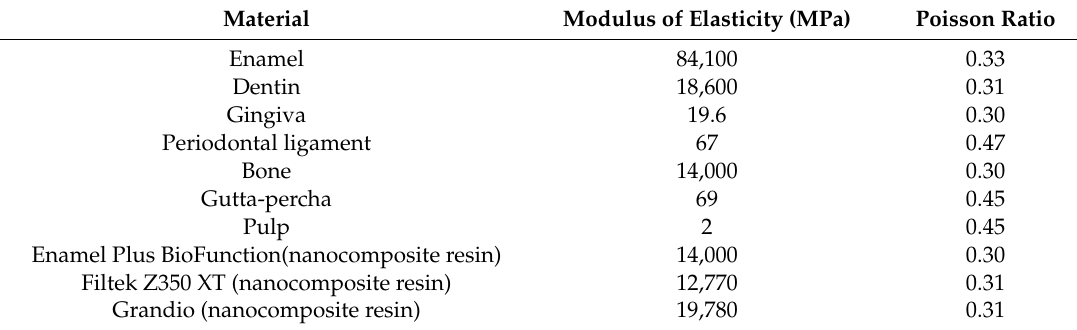
Table 1. Mechanical properties used for the isotropic materials included in the experimental model.